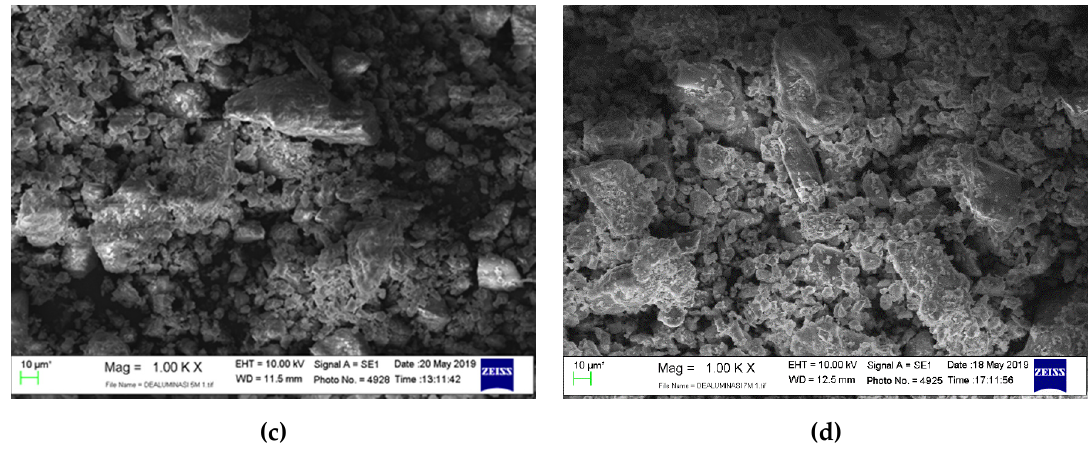
Figure 2. SEM morphology at 100 times magnification for catalysts of ( a ) Z, ( b ) Z3, ( c ) Z5, and ( d ) Z7.